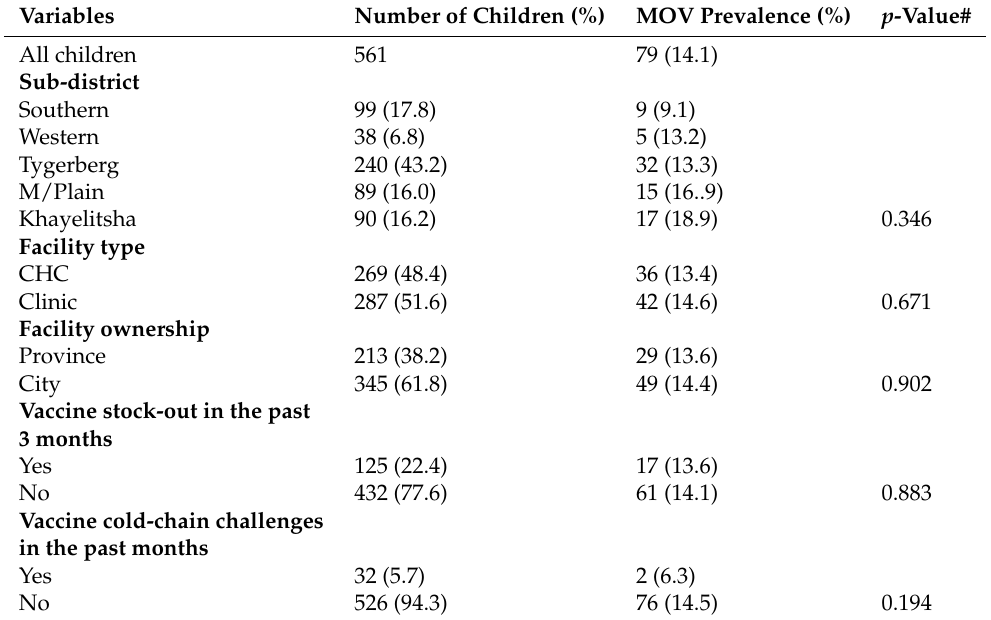
Table 2. Prevalence of missed opportunities for vaccination among children aged 0–23 months attending primary healthcare facilities in Cape Town.